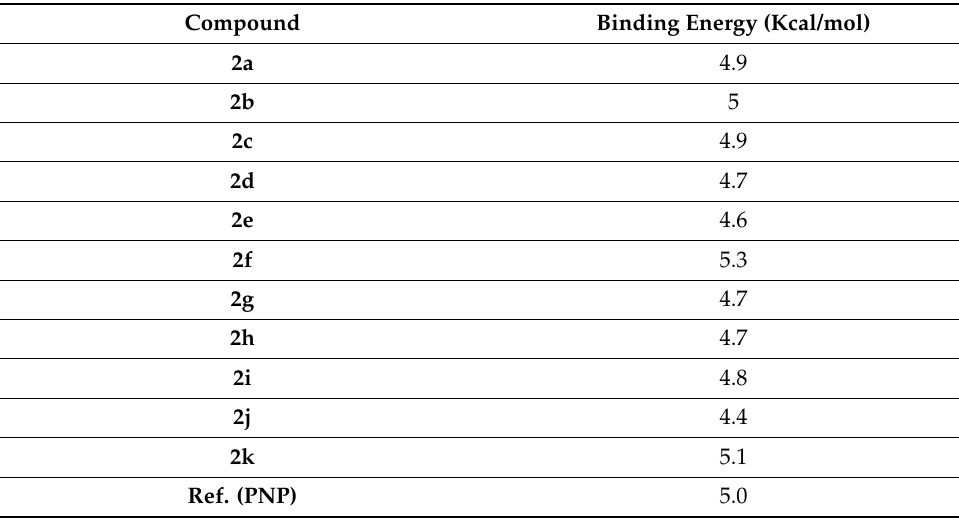
Table 4. The docking energy values of all synthetic